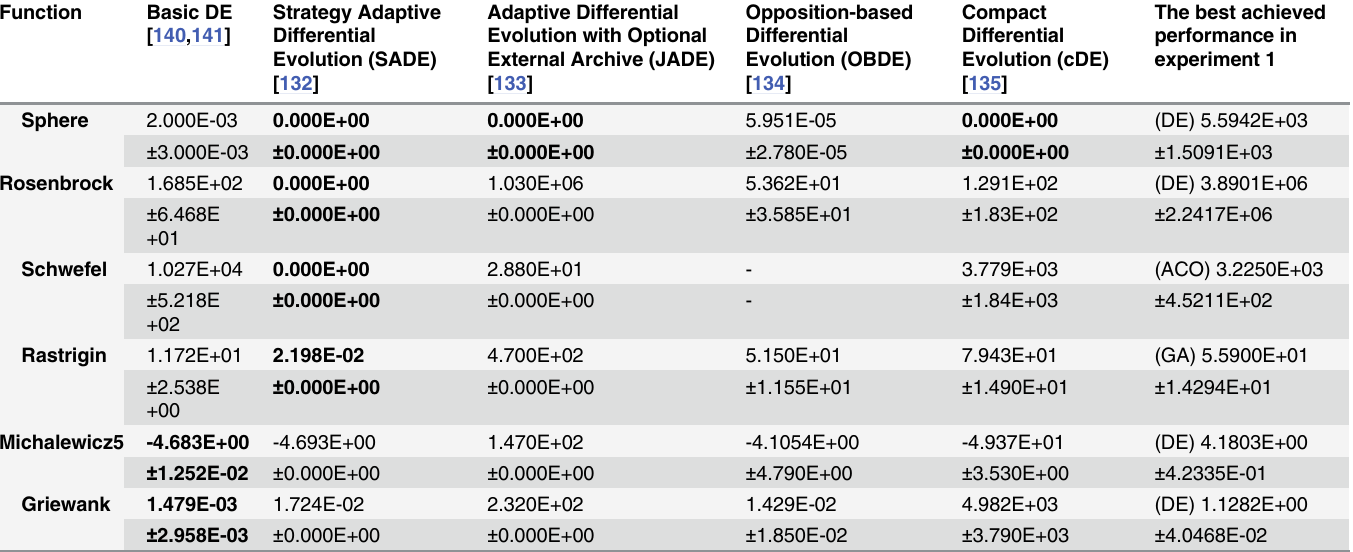
Table 10. Comparison of various DE-based algorithms (Mean ± SD).